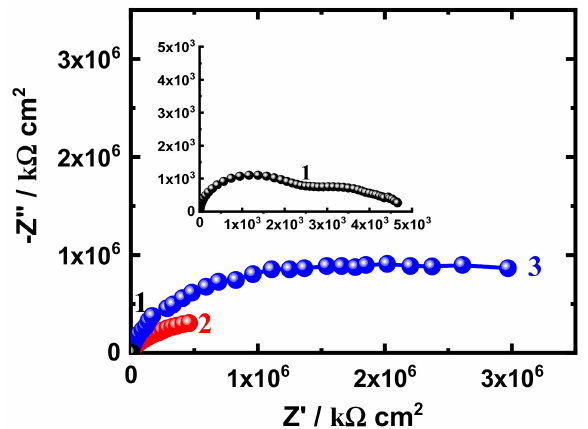
Figure 6. Nyquist plots obtained for (1) SN1, (2) SN3, and (3) SN5 after their immersion for 5 days in 3.5% NaCl solutions.